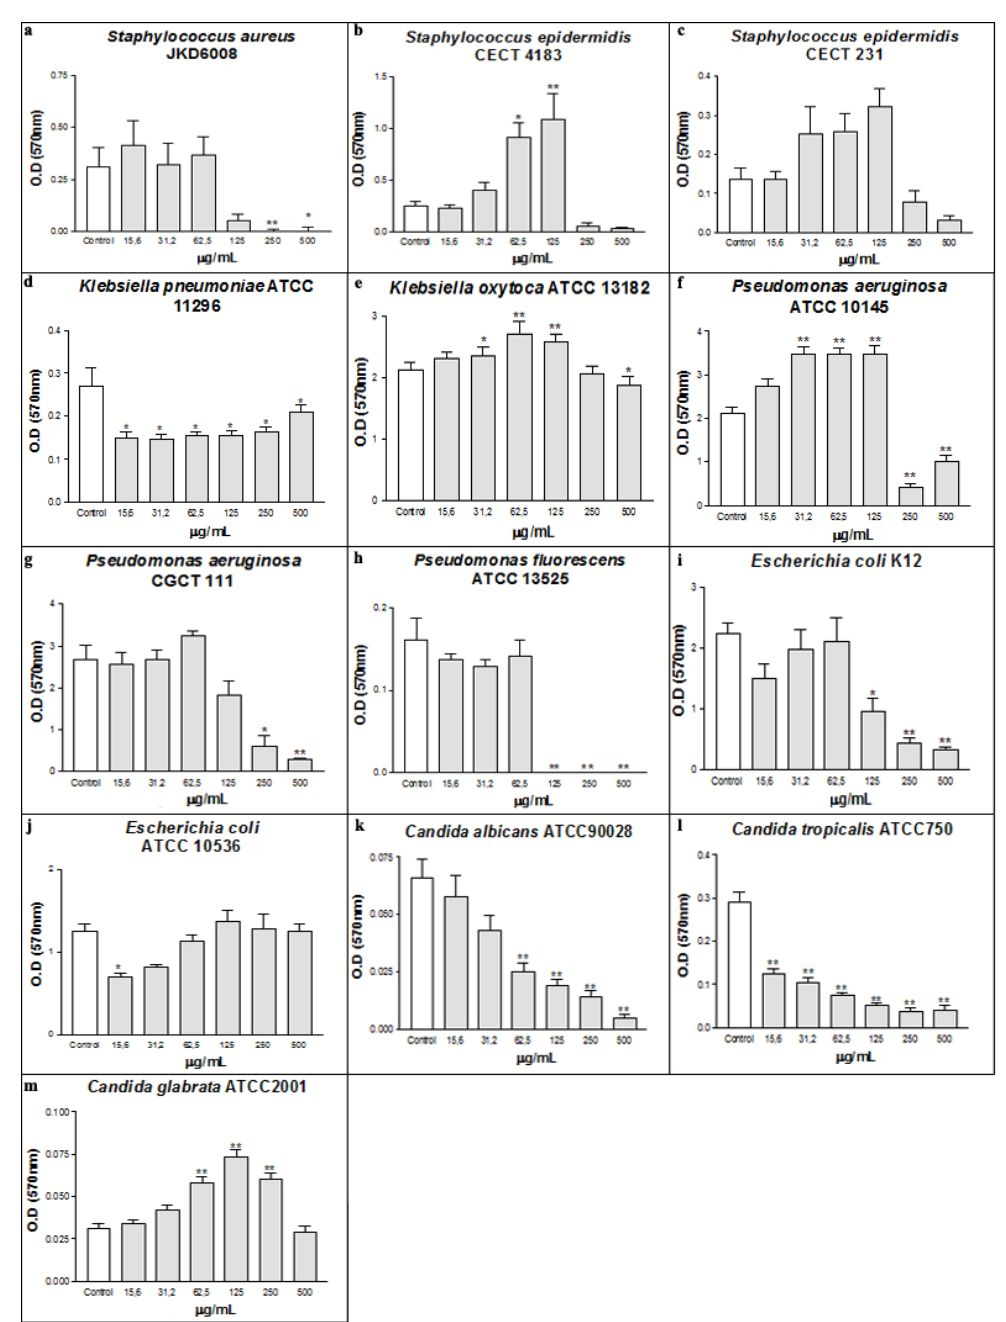
Figure 1. Antimicrobial activity of CD on the planktonic growth of bacterial (a-j) and yeasts (k-m). * p < 0.01 and ** p < 0.001 related to